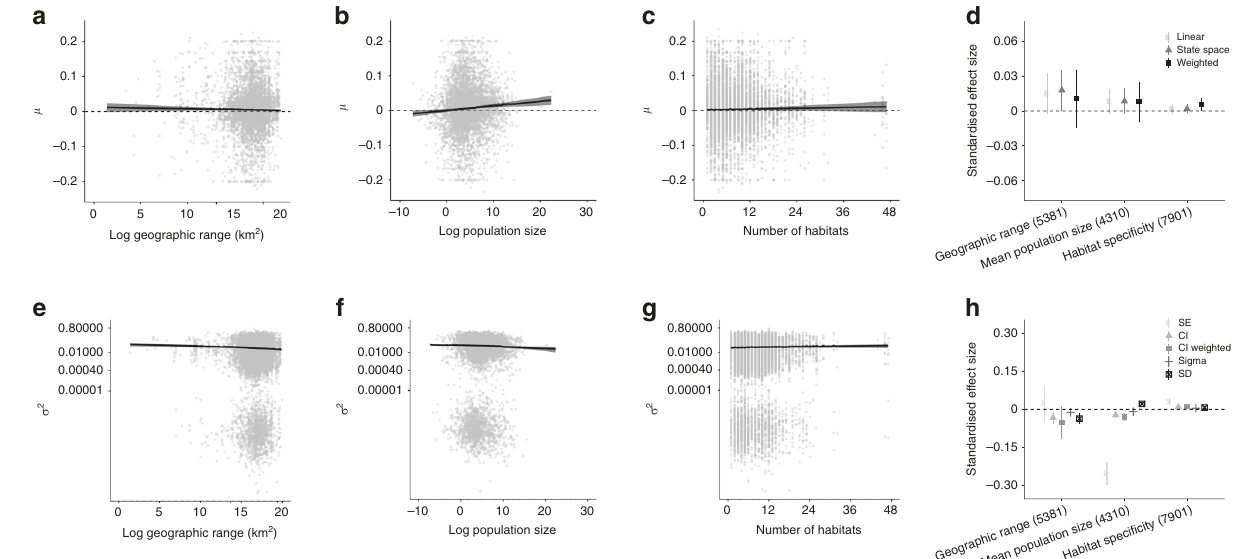
Fig. 3 Rarity metrics do not explain heterogeneity in local population trends, and both rare and common species experienced declines and increases over time, whereas smaller populations fl uctuated more over time. Numbers on plots show sample size for each metric. Rarity metrics were calculated for all species for which information was available and cover all taxa represented in the Living Planet Database, with the exception of geographic range, which refers to the global range of only bird and mammal species in the global Living Planet Database a – e . The μ values of population trend a – c and the σ 2 values of population fl uctuation e – g were derived from state-space model fi ts of changes in abundance over time for each population. d , h show the standardised effect sizes (centre of error bars) and the 95% credible intervals of three rarity metrics on population trends d and fl uctuations h . Lines on a – c and e – g show model fi ts and 95% credible intervals. See Fig. 1 caption for further details on effect sizes, Supplementary Fig. 14 for UK-scale analyses and Supplementary Table 2 for model